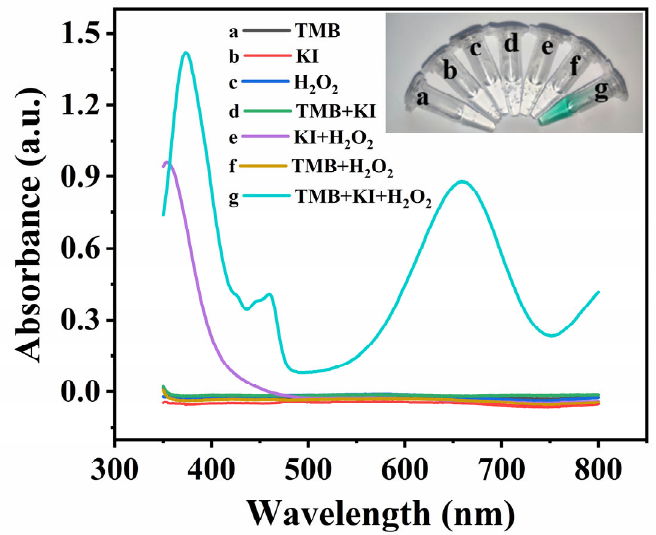
Figure 2. UV–Vis absorption spectra of the solutions with different components. Insert is the photograph of the solutions.